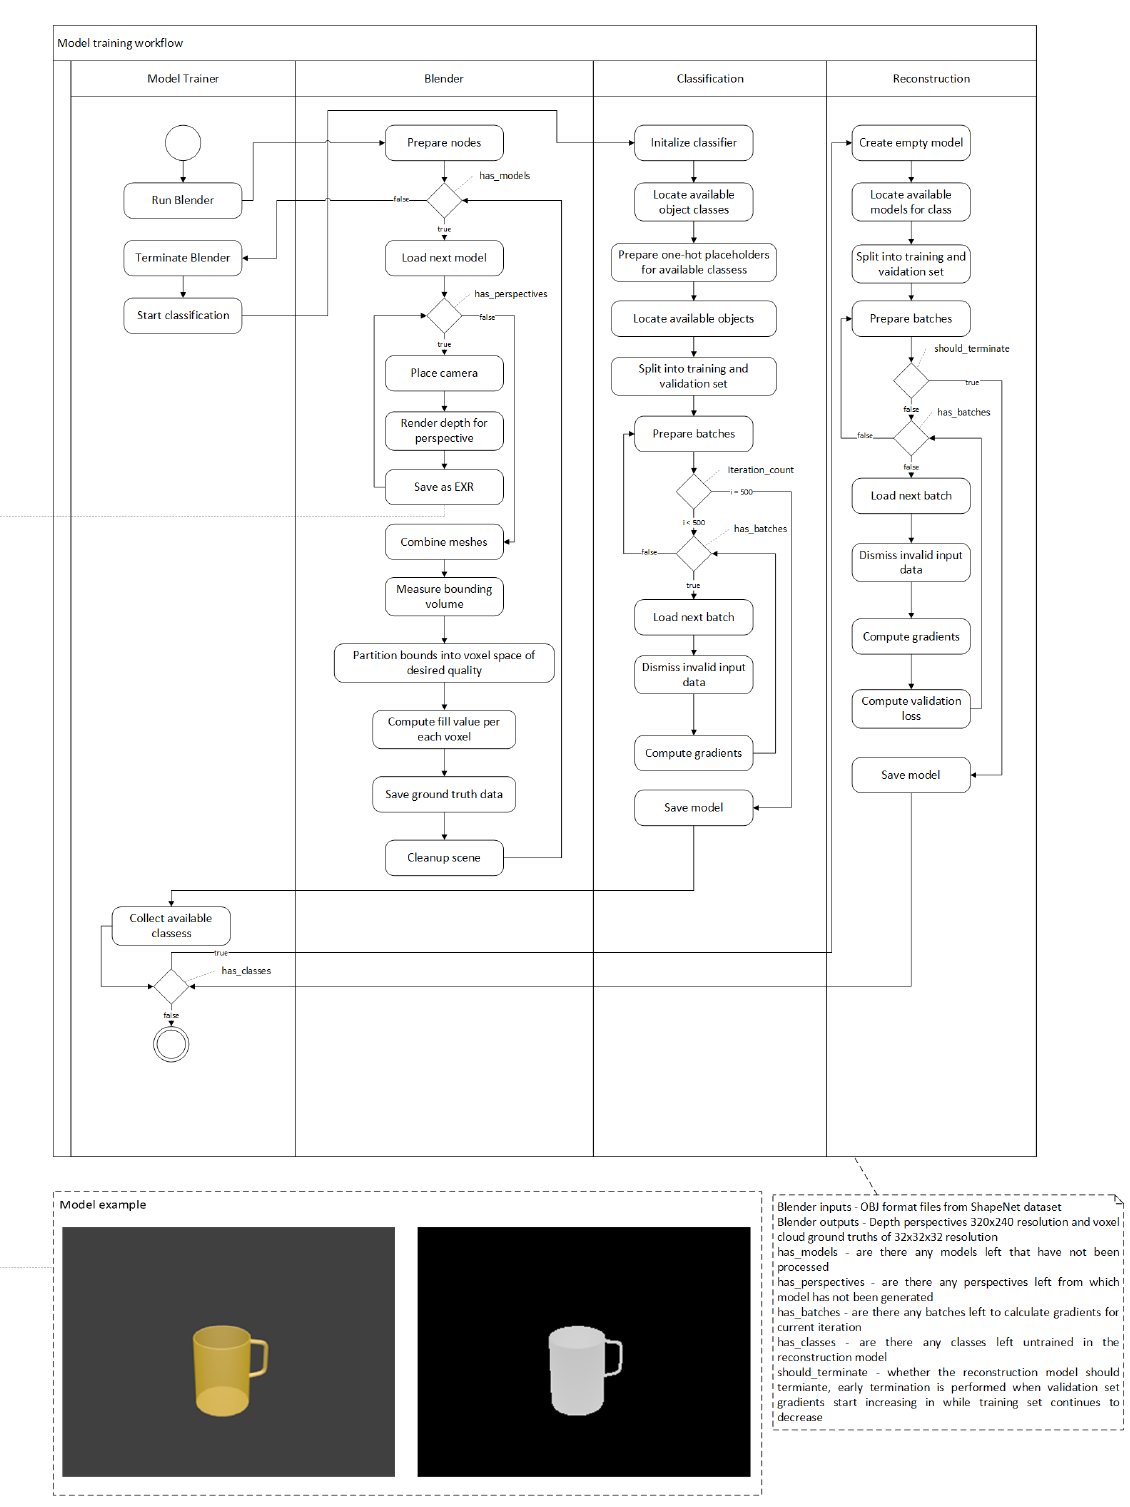
Figure 5. Overview of workflow for ShapeNetCore data set preparation and model